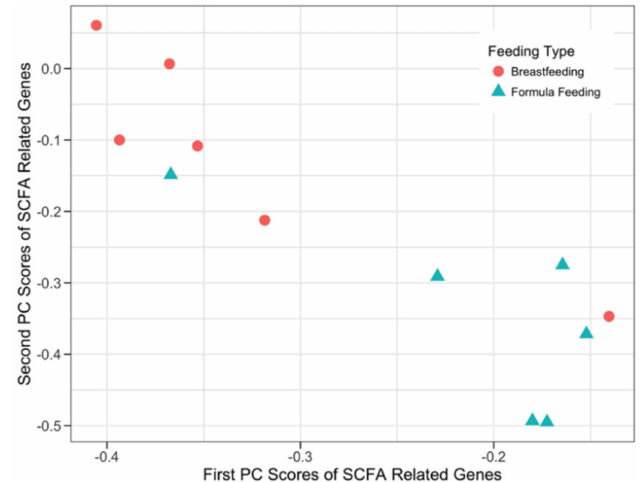
Figure 2. Sparse Principal Component Analysis (sPCA) results for the short-chain fatty acids (SCFA) receptor related host genes. The x-axis and the y-axis represent the first and the second principal components obtained after the sPCA application to the normalized microarray expression of SCFA receptor-related host genes, respectively. A total of 33 out of 72 SCFA receptor-related genes participated in the first two principal components of this sPCA